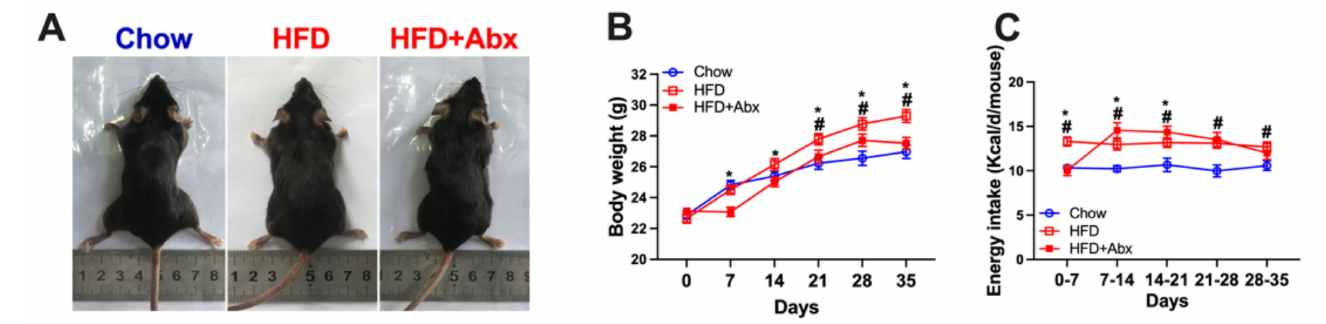
Figure 4. Gut microbiota depletion decreased body weight in HFD-fed mice. ( A ) Representative mice in the Chow, HFD, and HFD+Abx groups; ( B ) body weight; ( C ) energy intake. Data were expressed as the mean ± SEM. * p < 0.05 compared to HFD+Abx; # p < 0.05 compared to